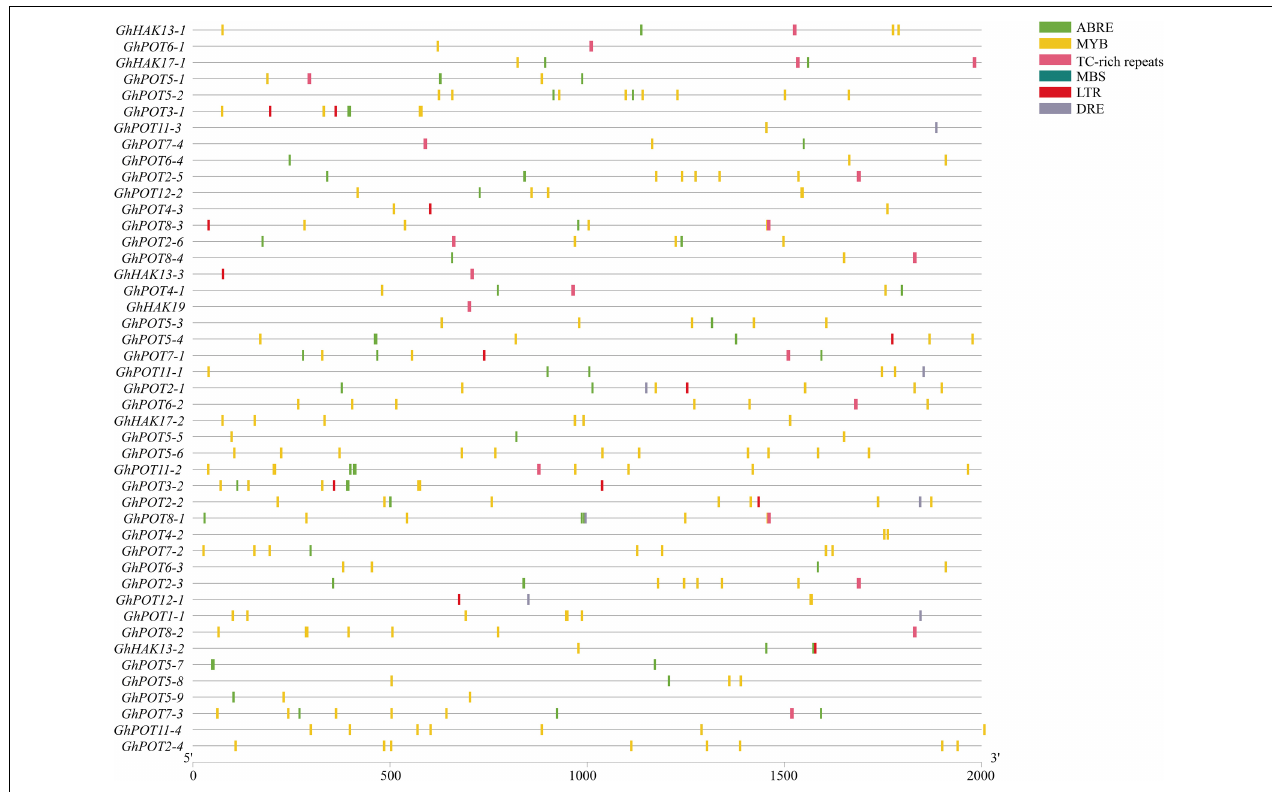
FIGURE 4 | Distribution of major stress-related cis -elements in the promoter regions of GhPOTs. The locations of these cis -elements were confirmed using the PlantCARE database. Different cis -elements are represented by boxes of different colors.